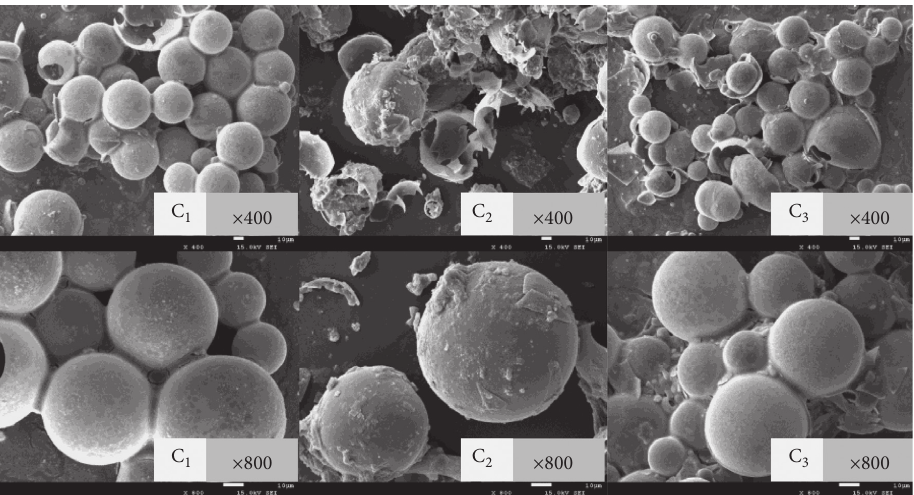
Figure 11: SEM tests of the three HGM composites.